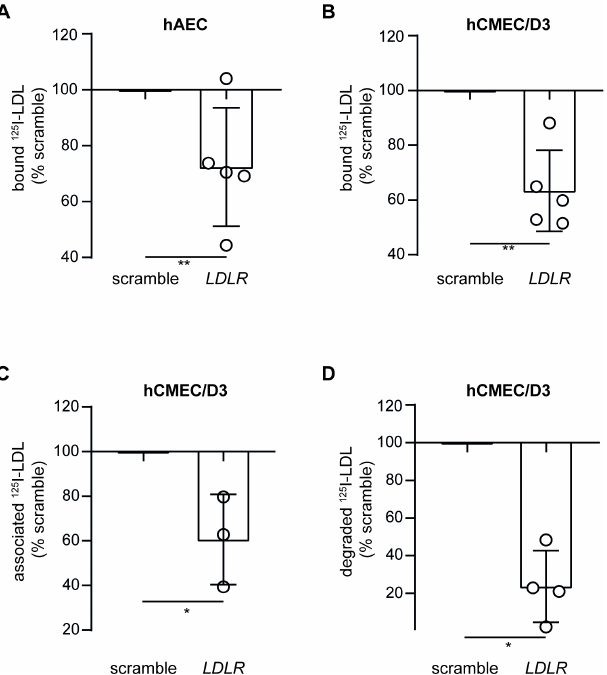
Figure 3. Knocking down LDLR reduces LDL binding, association, and degradation in hCMEC/D3. Seventy-two hours after silencing LDLR using siRNA, I 125 -LDL binding (4 ◦ C) to hAEC ( A ) or hCMEC/D3 ( B ) was measured as described in Figure 1. To further investigate the interaction of LDL with hCMEC/D3, I 125 -LDL association (1 h at 37 ◦ C) ( C ) and degradation (4 h at 37 ◦ C) ( D ) were measured as above. Points in graphs represent individual experiments (biological replicates, n = 3–5), bars represent the mean and error bars ± SD, * p = 0.05 and ** p =